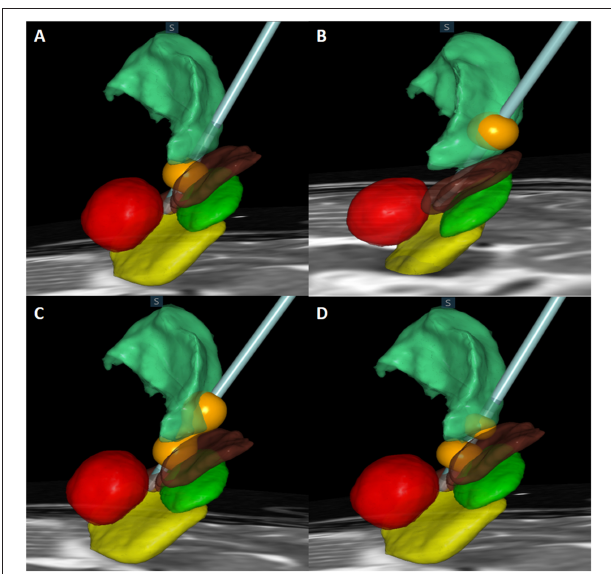
FIGURE 3 | Actual electrode and contact of stimulation in relation to the subthalamic nucleus (STN) (green), substantia nigra (SNr) (yellow), red nucleus (red), zona incerta (Zi) (brown), and ventralis intermedius (VIM) (light green) are shown. (A) Monopolar stimulation of contact 1 located in the Zi. (B) Monopolar stimulation of contact 3 located in the VIM. (C) Dual stimulation of contact 1 in the Zi and contact 3 in the VIM. (D) Bipolar stimulation of contacts 1 and